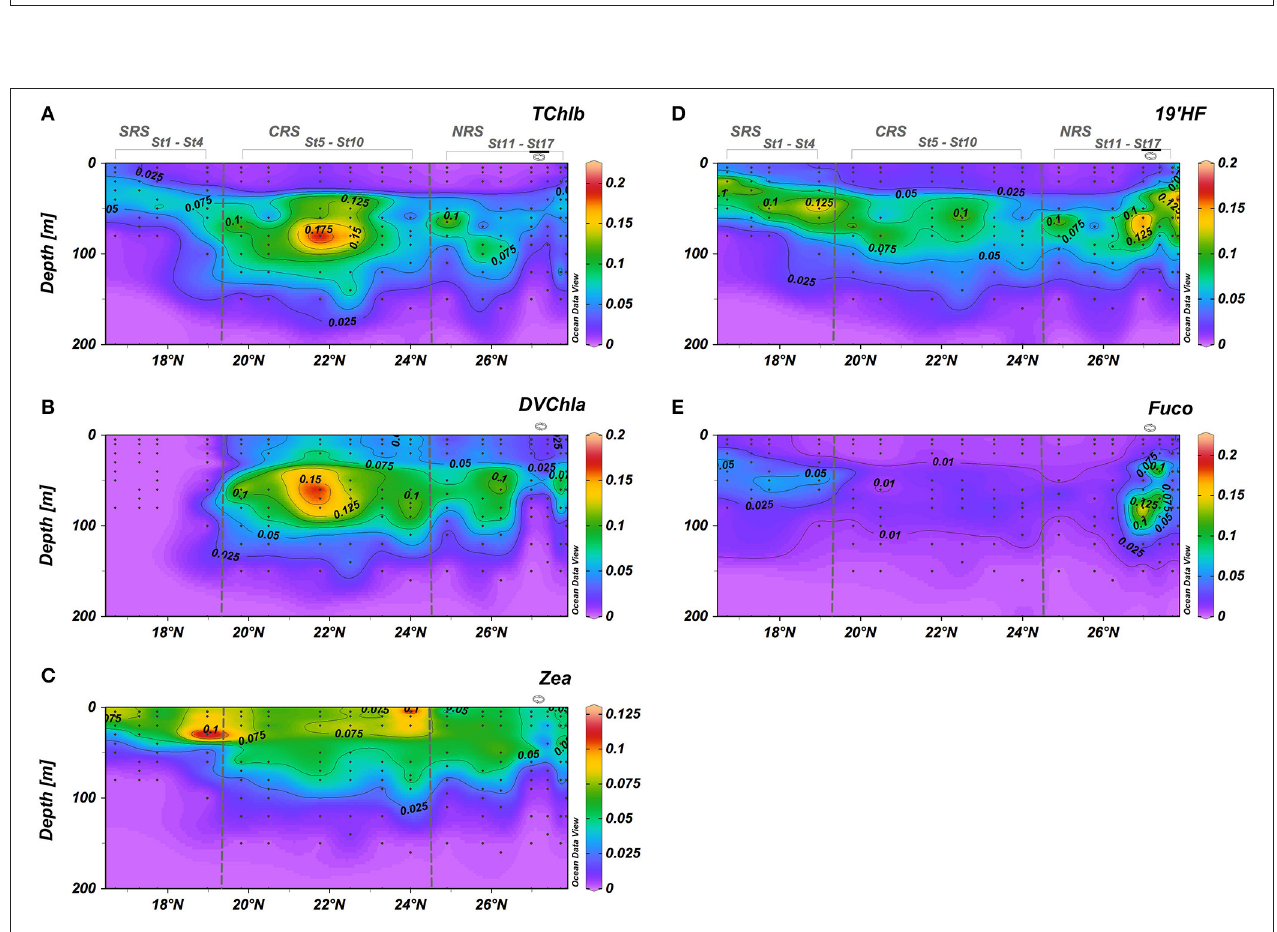
FIGURE 4 | Vertical cross sections for pigment concentrations (mg m − 3 ) across the south-north transect. (A) Total chlorophyll-b; (B) Divinyl chlorophyll-a; (C) Zeaxanthin; (D) 19 ′ Hexanoyloxyfucoxanthin; (E) Fucoxanthin. Black dots represent sampling points. Eddy stations marked along the top of the upper graph.